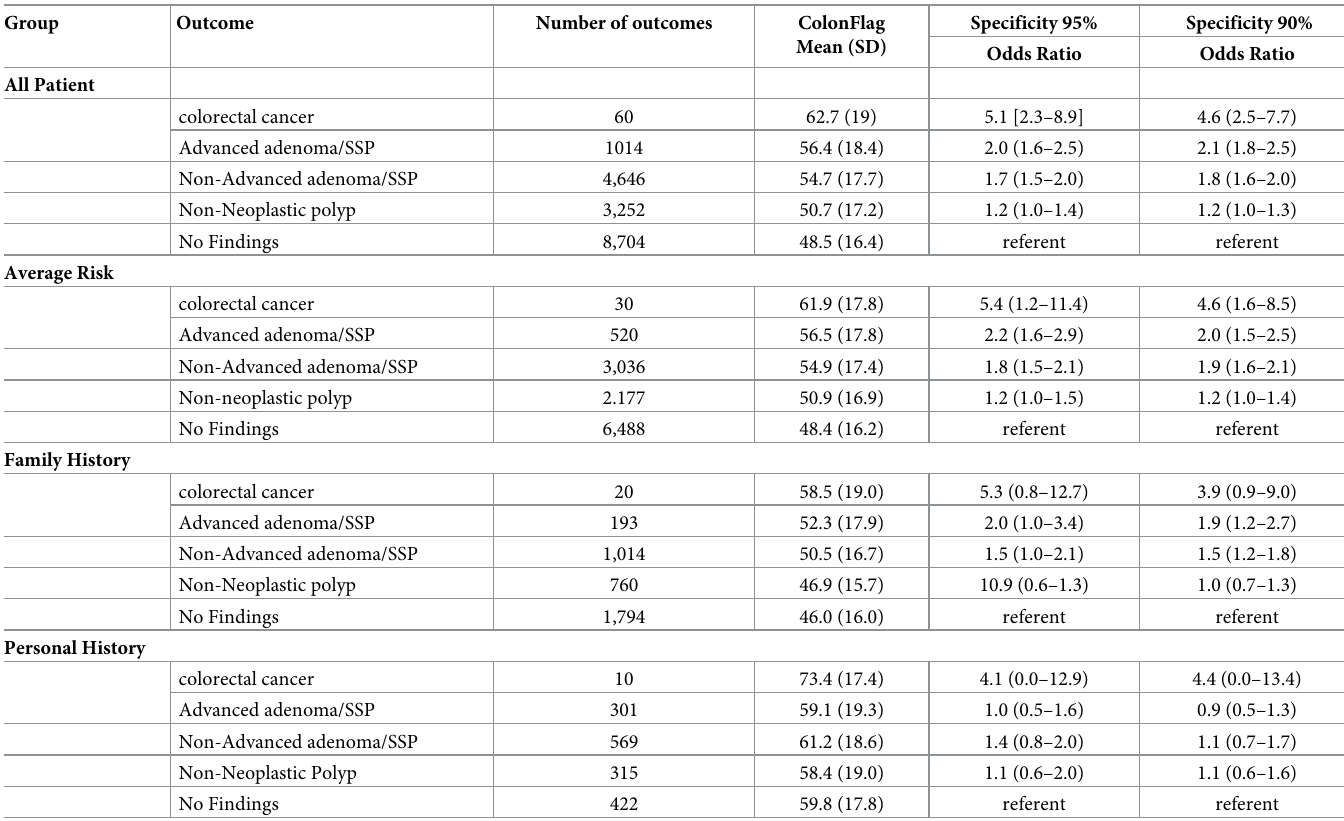
Table 2. Odds ratio of a positive colonflag, by patient subgroup.